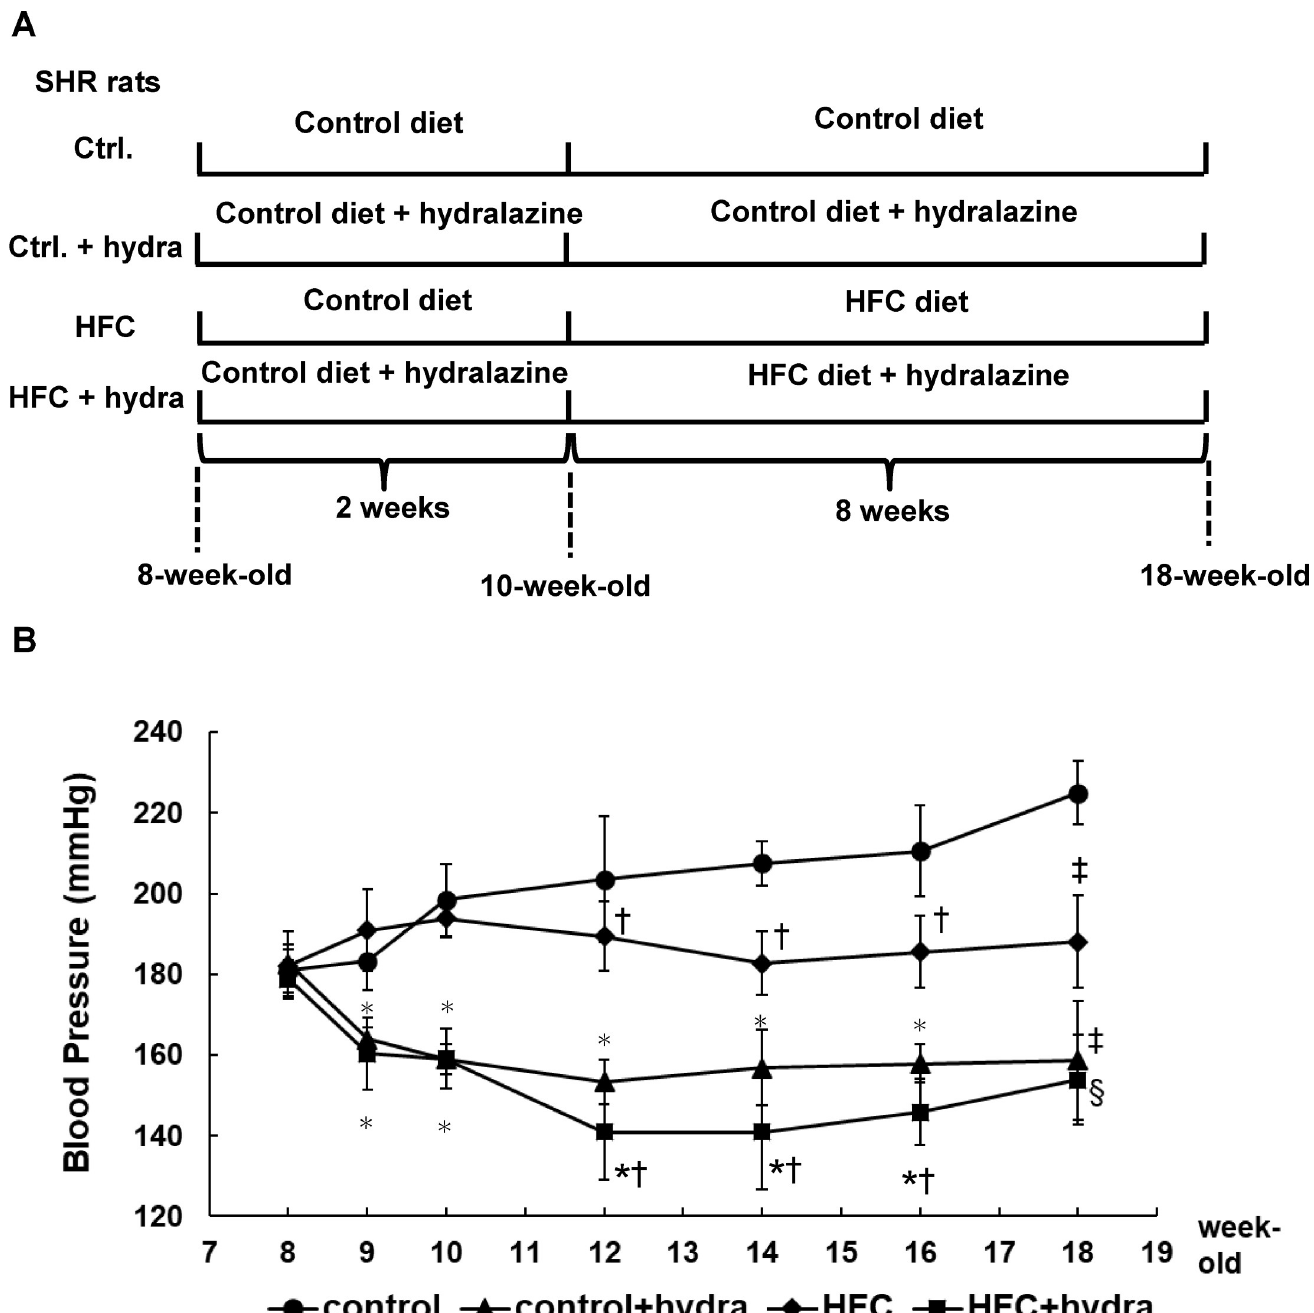
Fig 1. Experimental procedures and measurement of blood pressure. The experimental procedures (A). The 8-week-old male SHRs were randomly divided into 4 groups ( n = 6) and fed control diet with or without hydralazine treatment (7.36 mg/kg body weight/day) for 2 weeks. Then they were fed HFC or control diet in the presence or absence of hydralazine for 8 weeks before the sacrifice. The effect of hydralazine on systolic blood pressure of SHRs (B). � P < 0.05 between control diet and HFC diet groups (two-way ANOVA); † P < 0.05 between with and without hydralazine groups (two-way ANOVA); ‡ P < 0.05 vs control diet group (one-way ANOVA); § P < 0.05 vs control diet with hydralazine treatment (one-way ANOVA).